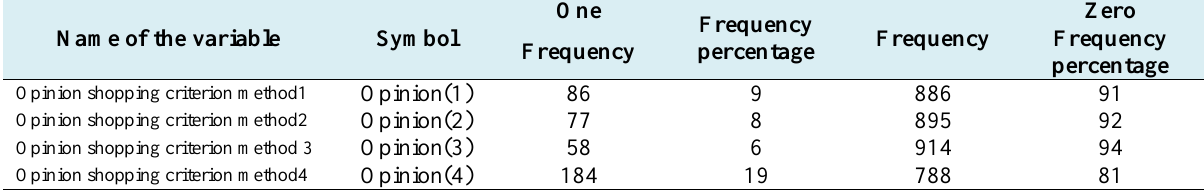
Table 2. Frequency of (binary) variables zero and one related to models of research hypotheses